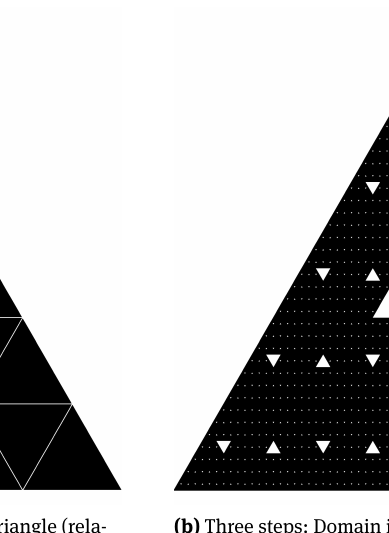
Figure 1: Construction of a non-self-similar triangular version of a Sierpiński